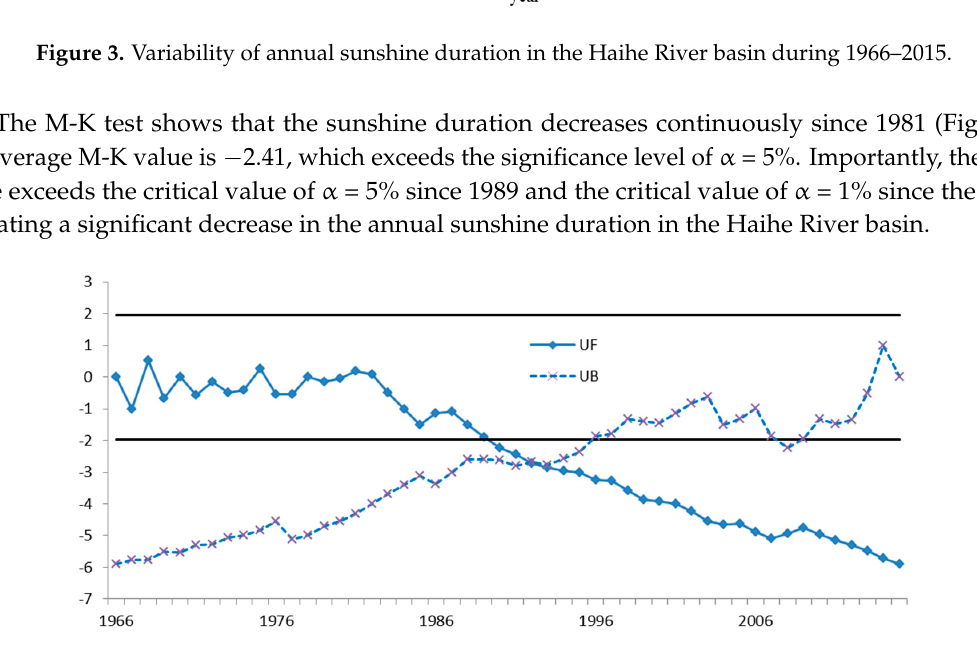
Figure 4. Mann-Kendall (M-K) test of annual sunshine duration in Haihe River basin during 1966– 2015.